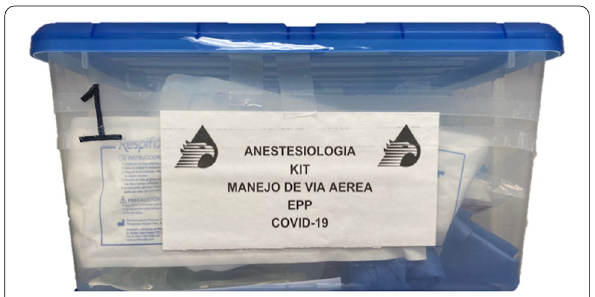
Fig. 3 The COVID‑19 dedicated airway box used for airway management and placed close to patient together with the aerosol